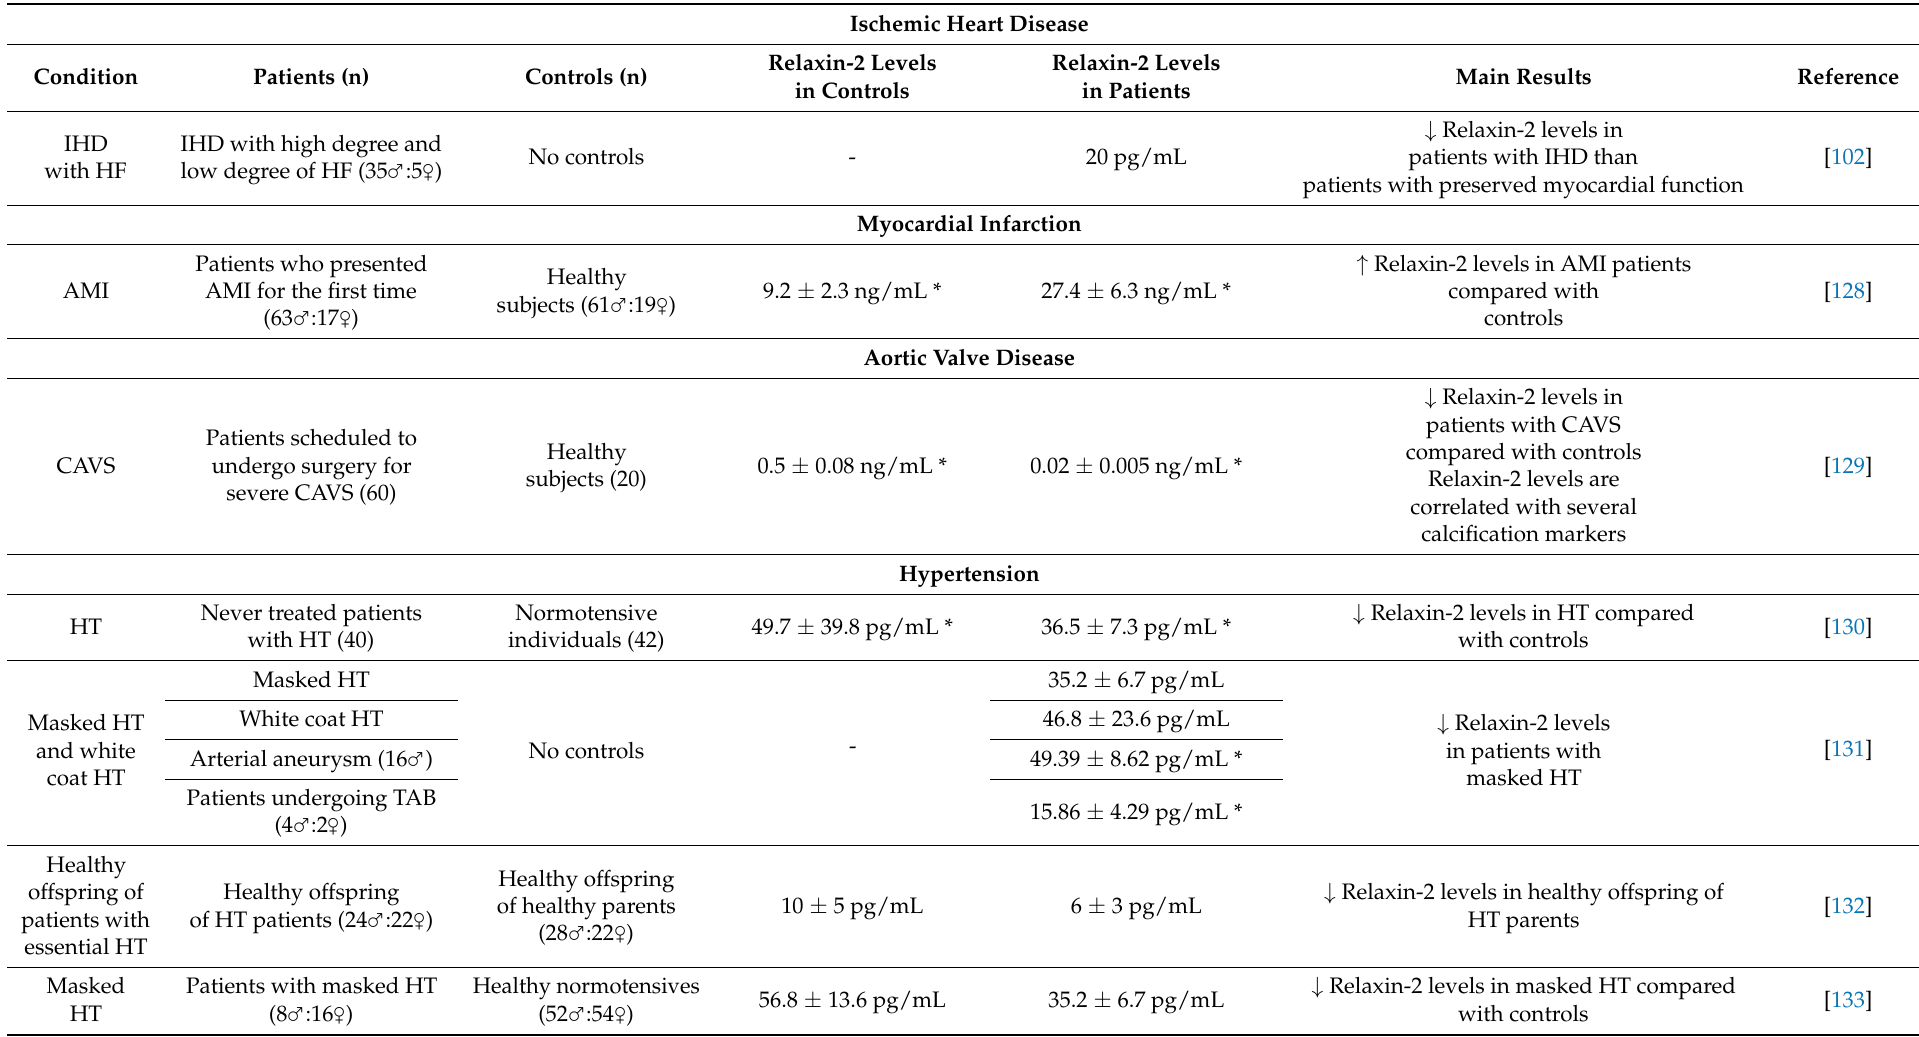
Table 4. Relaxin-2 plasma or serum levels during ischemic heart disease, myocardial infarction (MI), aortic valve disease, hypertension, and atherosclerosis. Ischemic Heart